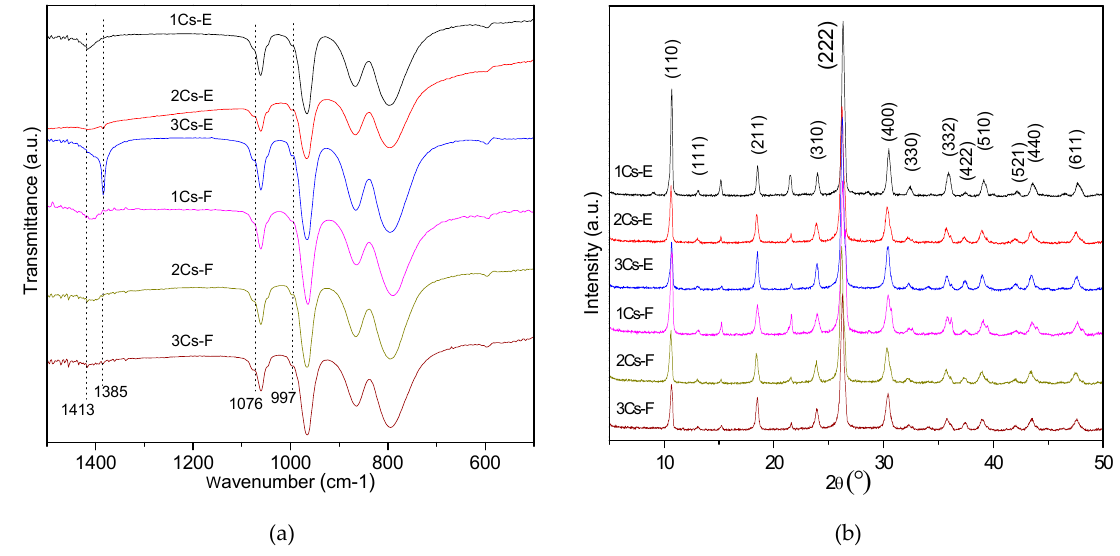
Figure 1. Flourier transformation infrared (FT-IR) spectra ( a ); and X-ray diffraction (XRD) patterns ( b ) of the initial precipitates and the evaporation residues.